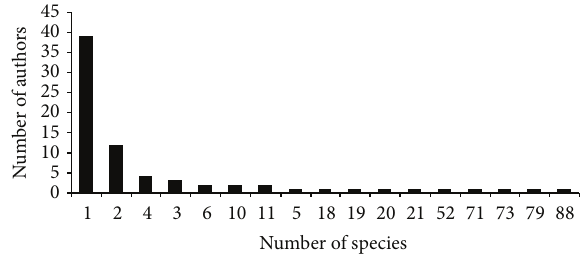
Figure 5: Number of authors in relation to the numbers of species of Paussini that they